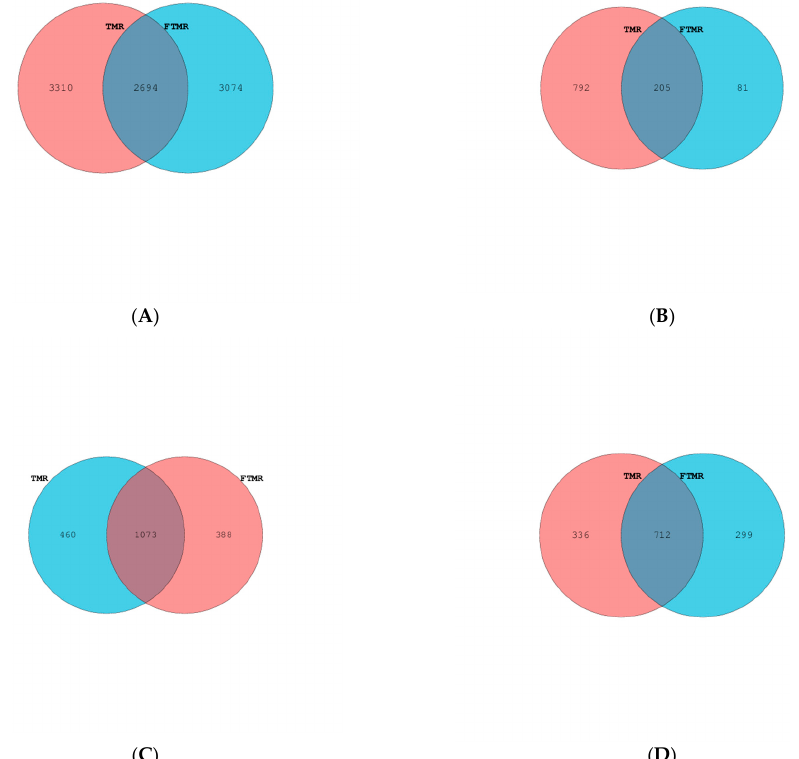
Figure 1. Venn diagram illustrating overlap of microbial OTUs (97% sequence identity) among treatments. Venn diagram of bacteria ( A ), ciliate protozoa ( B ), anaerobic fungi ( C ), and archaea ( D ) OTUs. TMR, total mixed ration; FTMR, fermentation total mixed